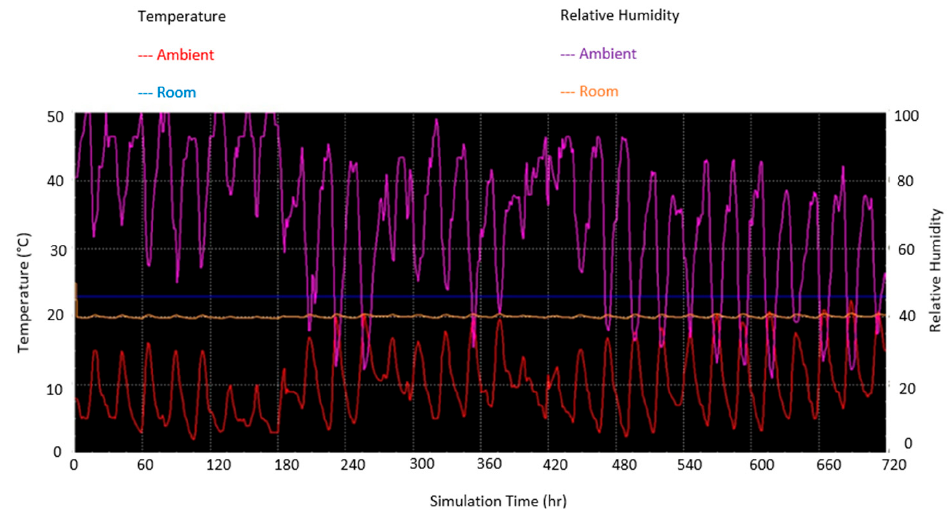
Figure 16. January simulation run for Option B.